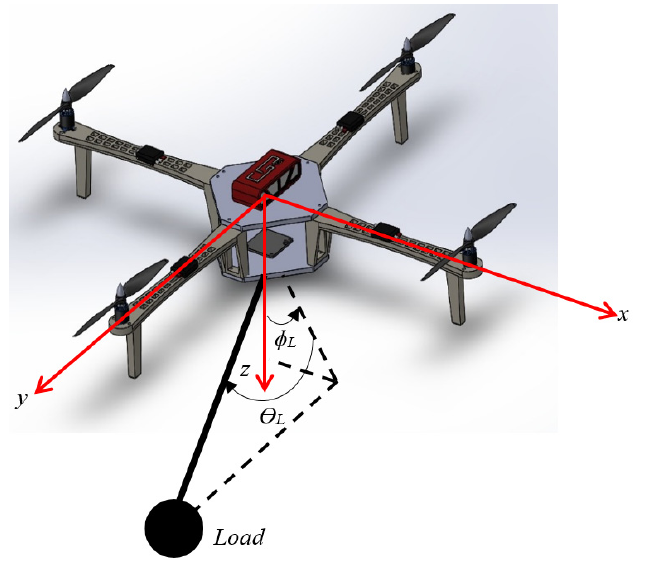
Figure 4. Description of the swing angles. In-plane swing angle ( ɸ L ) and out-of-plane swing angle ( ɵ L ).